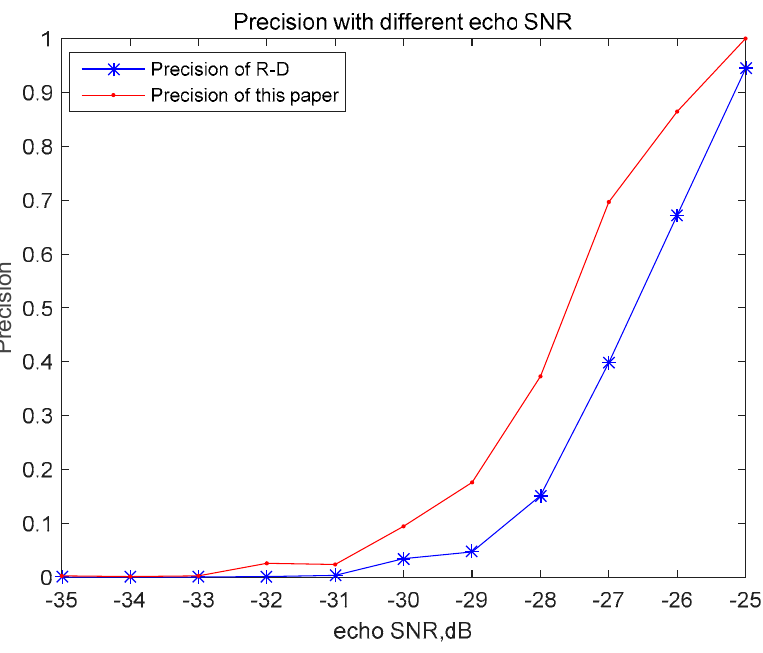
Figure 6. Precision of target detection with different noise power values ( N = 10 4 ).